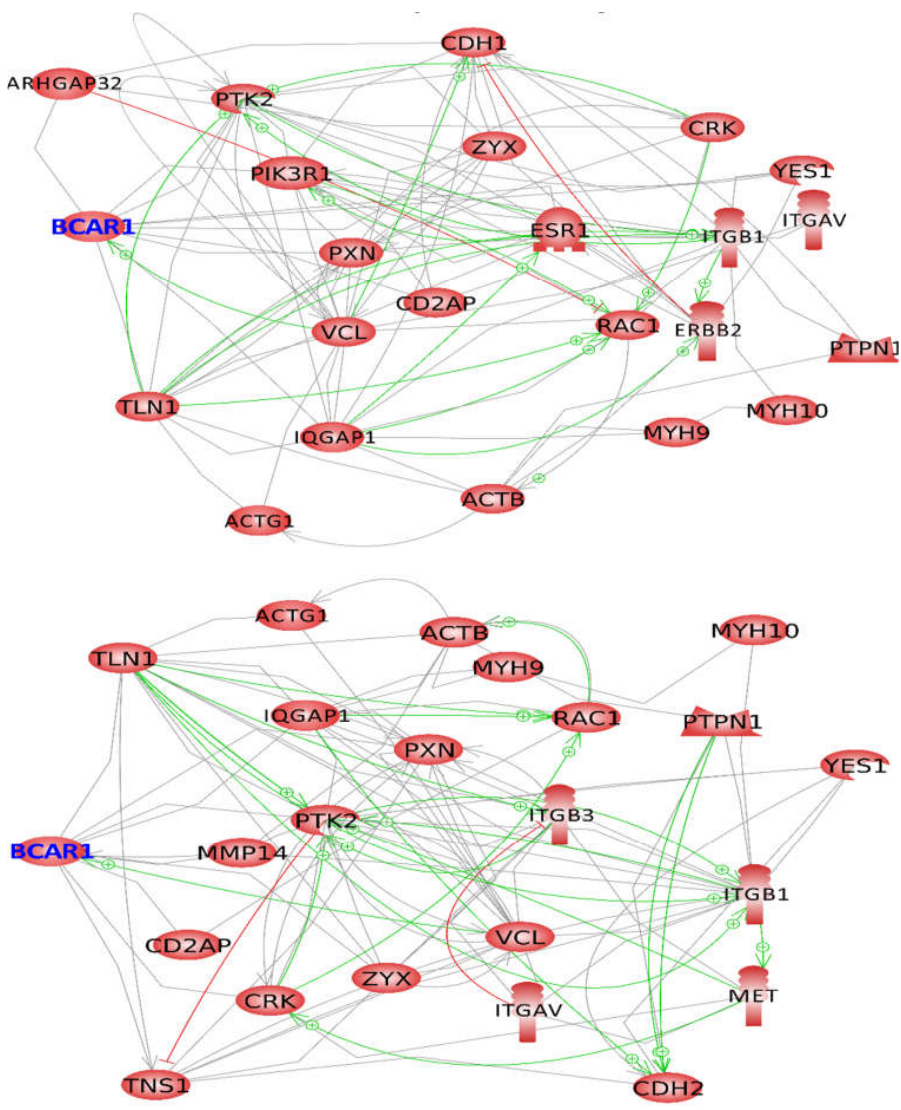
Figure 4. Selected proteins which form complexes with BCAR1, as indicated by gray lines. Of these proteins, TLN1 and IQGAP1 also form complexes with actins and myosins of MCF-7 breast cancer cells ( upper picture ) and of FTC-133 thyroid cancer cells ( lower picture ), establishing a link between the BCAR1 and the cytoskeleton. Regarding the cell–cell interaction proteins, CDH1 is connected to BCAR1 via PIK3R1 in MCF7 cells ( upper picture ), while CDH2 forms a complex with TNS1 and